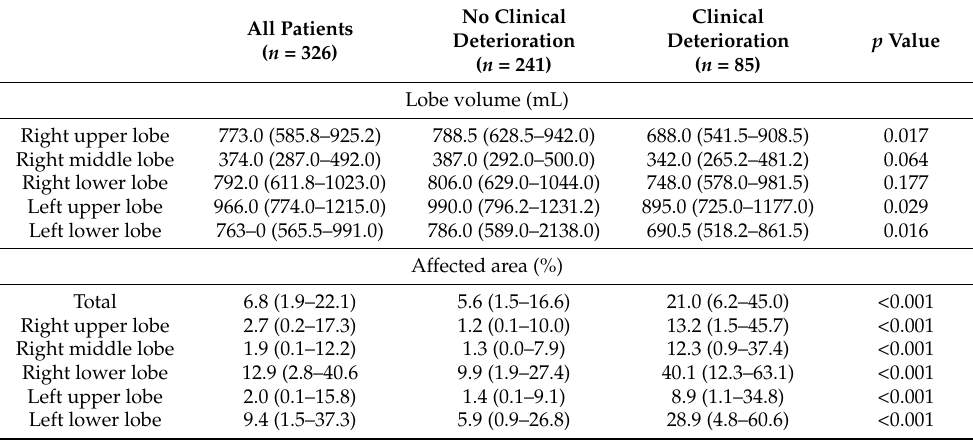
Table 3. AI-based chest CT quantitative